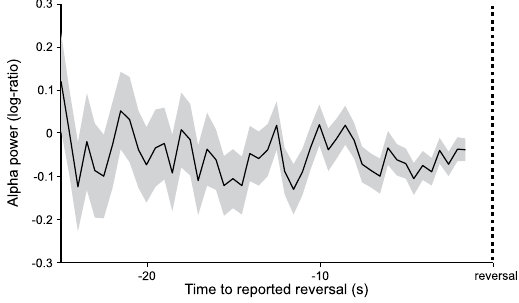
Figure 5. The time course of alpha power during the individual perceptual representations was stable during the period prior to a perceptual reversal. Values on the y-axis indicate the log of the ratio between alpha power on a sliding 1 s long window and alpha power in the interval of 1–2 s before the beginning of the individual perceptual representation. Gray areas indicate the standard error of the mean.